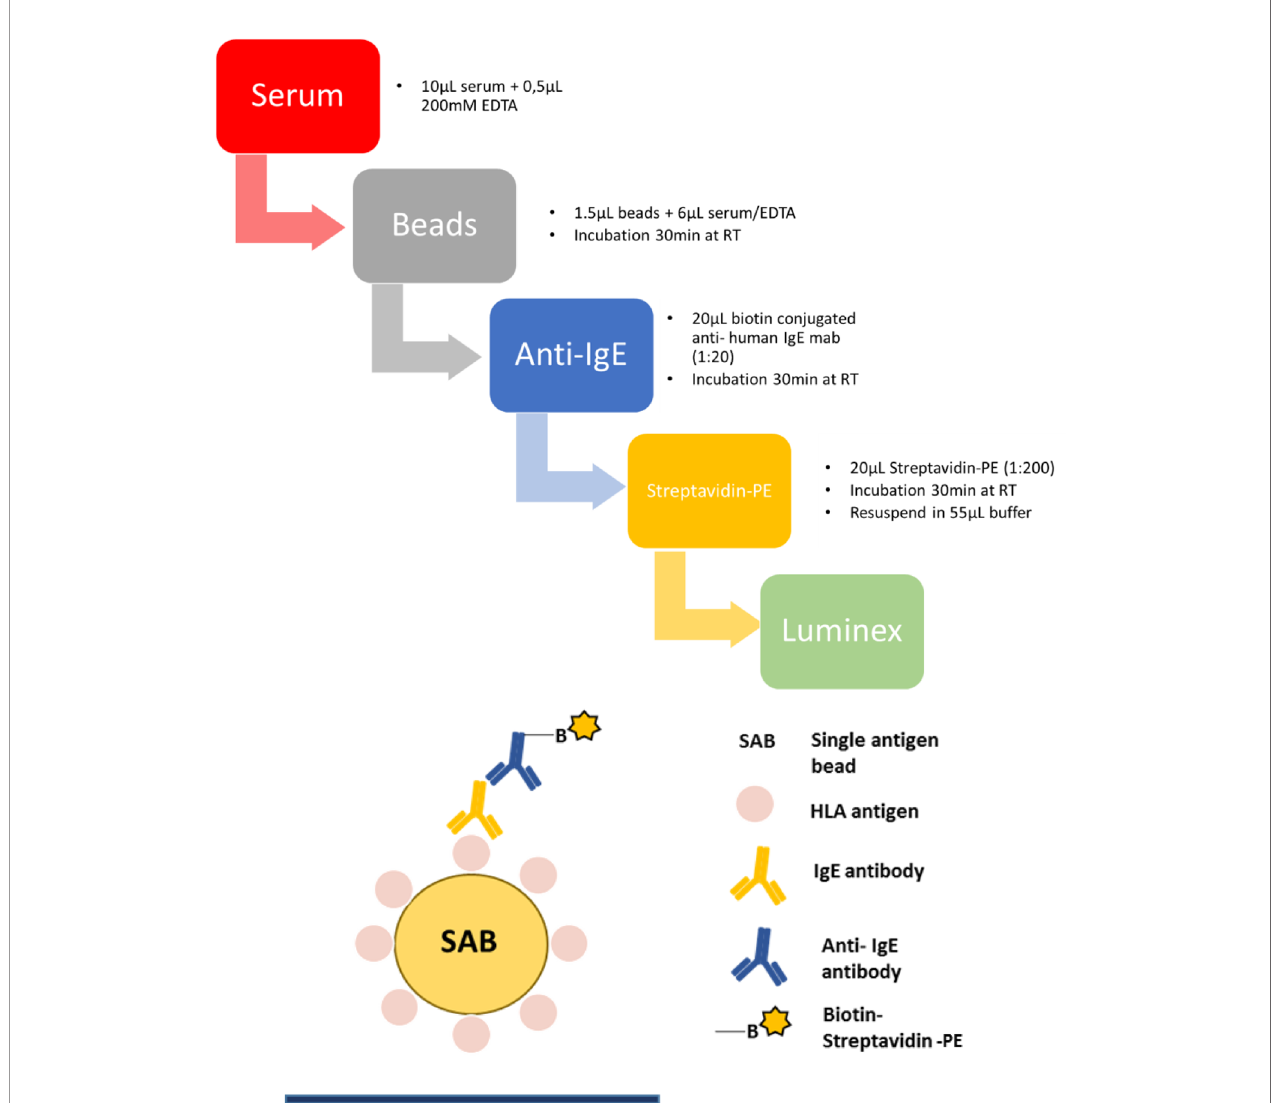
FIGURE 3 | Step by step protocol of detection HLA-speci fi c IgE in human serum with a luminex fl ow analyzer. Human serum sample was mixed with 10 mM EDTA and incubated with beads coated with single antigens at RT. After incubation, beads were washed twice with washing buffer and incubated with a monoclonal biotin conjugated anti-human IgE antibody. Beads are washed again twice, phycoerythrin (PE)-coupled streptavidin was added and after incubation and repeated washing steps beads were resuspended in 55 µl washing buffer and measured in a Luminex